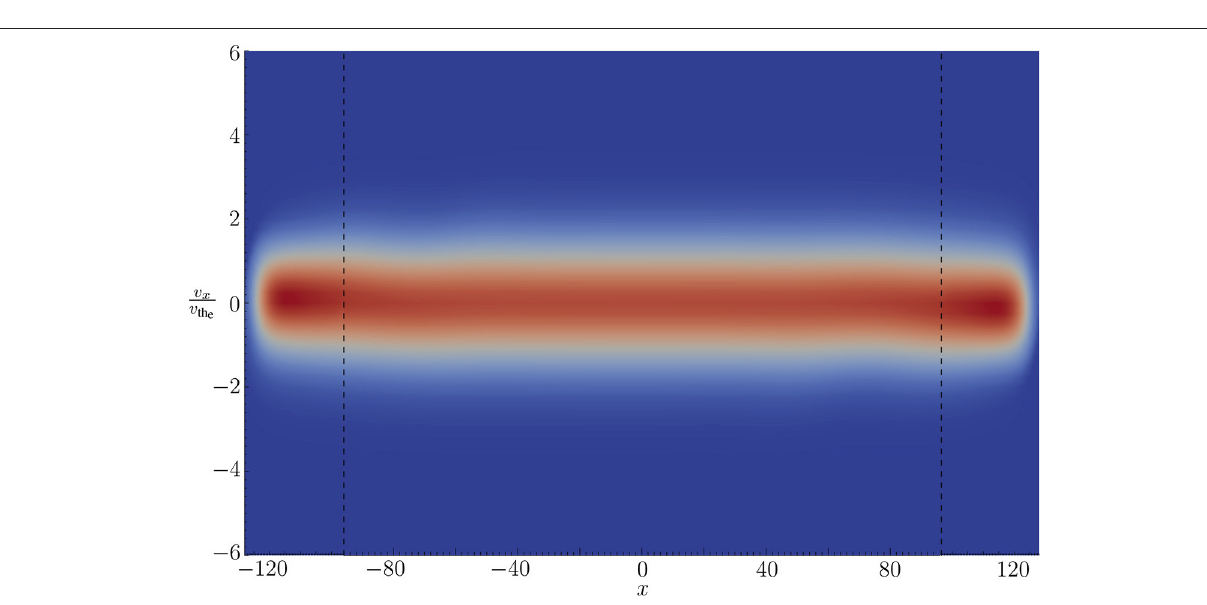
[ 96,96] is modeled with the ∈ −